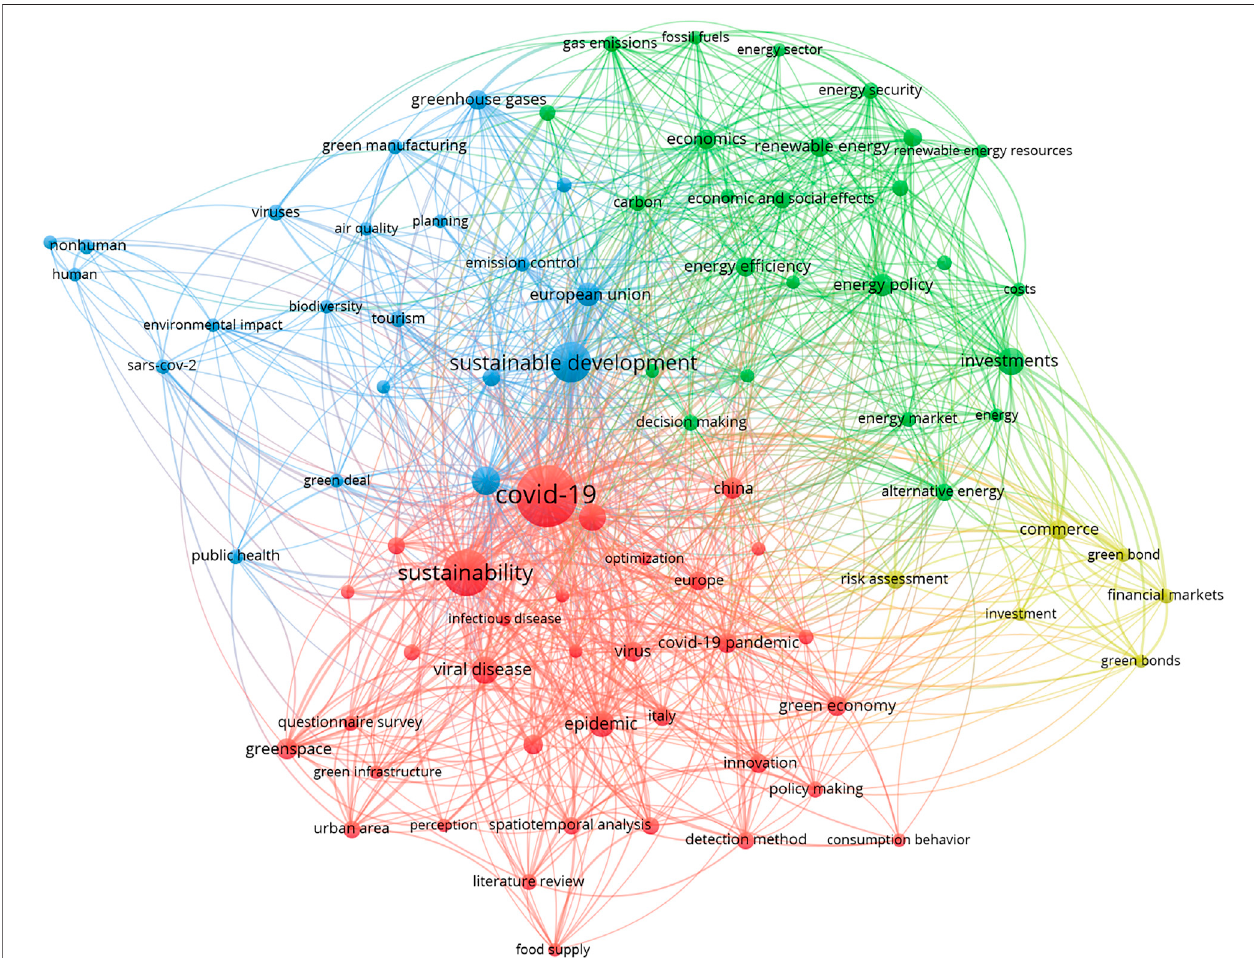
FIGURE 5 | Co-occurrence